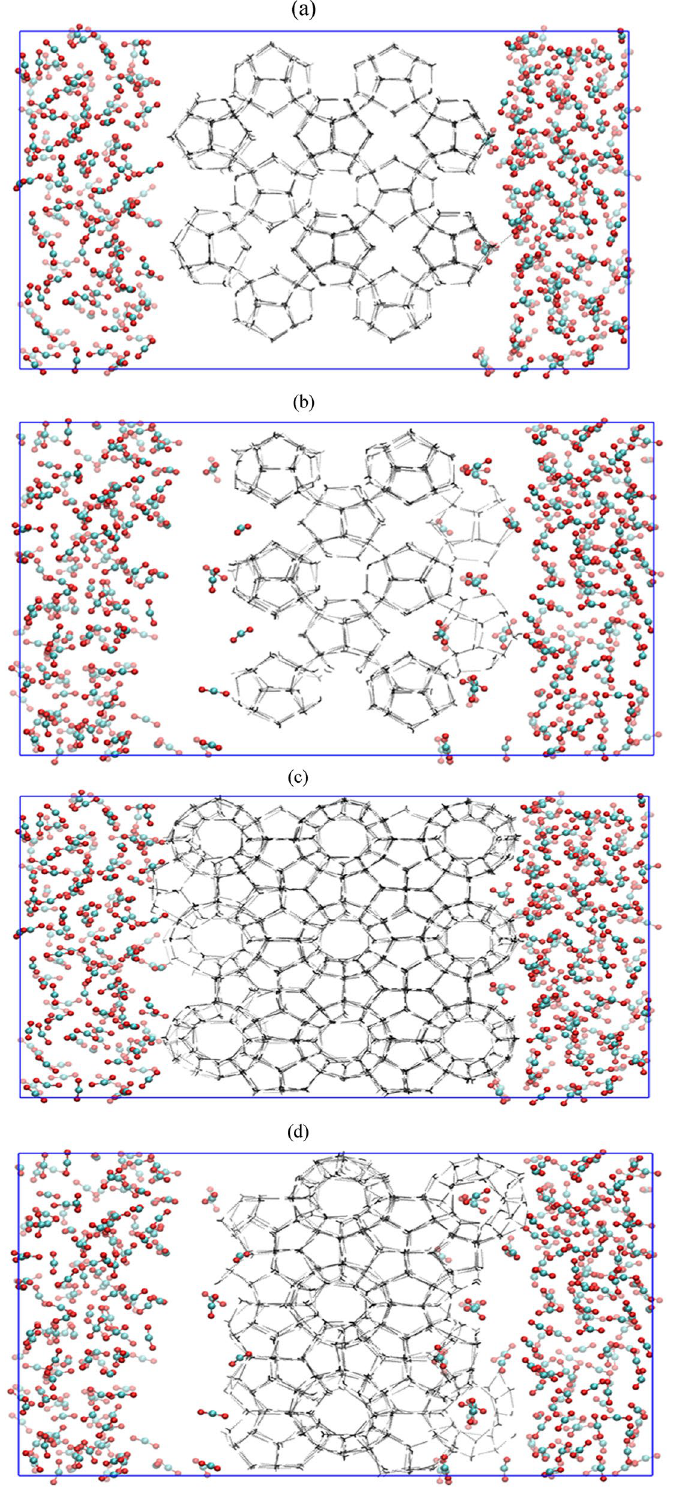
Figure 2. Cage-wise screenshot for the replacement of CH 4 by CO 2 in absence of free water molecules with operating pressure and temperature of 50 MPa and 260 K at ( a ) 0 µs (small cages), ( b ) 2 µs (small cages), ( c ) 0 µs (large cages) and ( d ) 2 µs (large